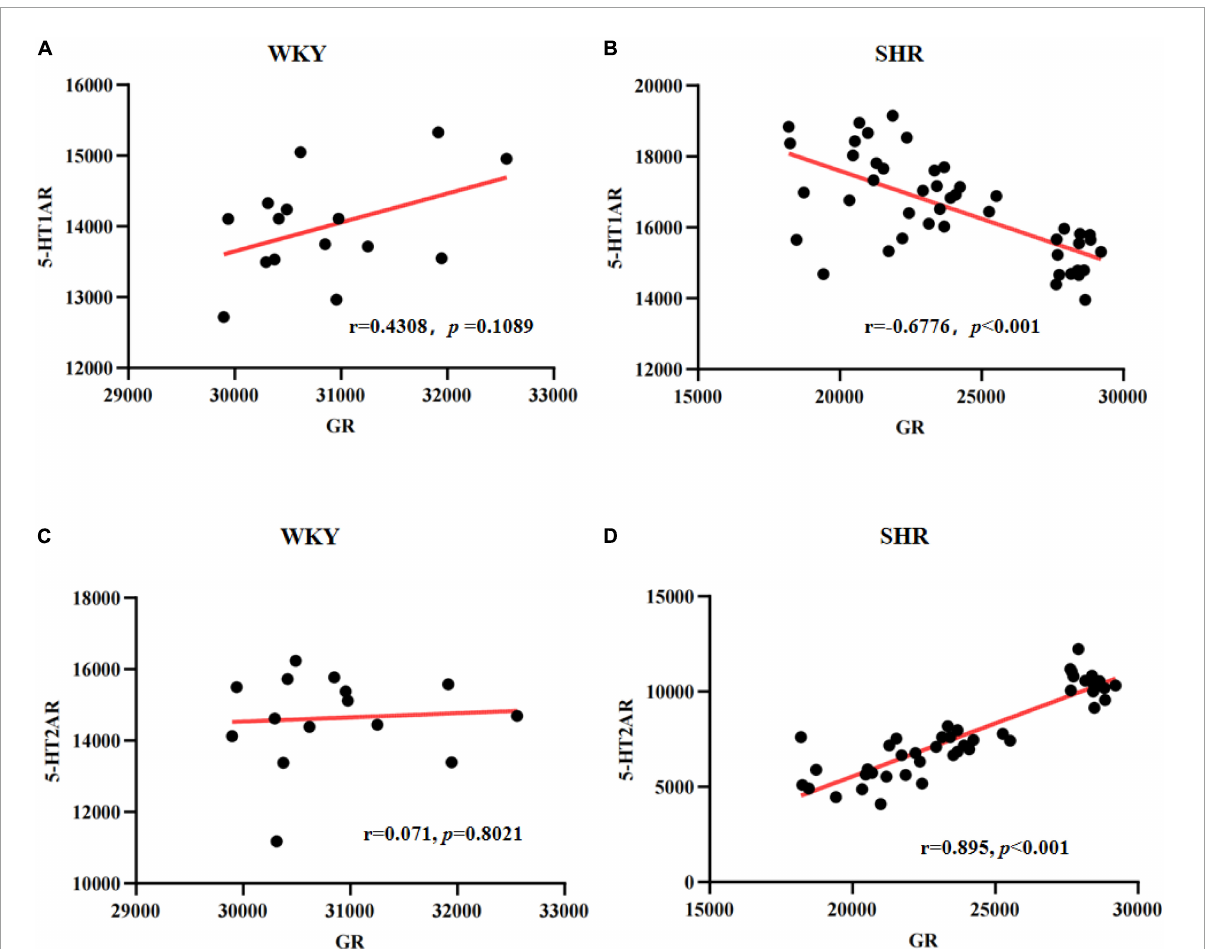
FIGURE8 Scatter plots for the correlation between glucocorticoid receptor (GR) and 5-HT1A receptor (5-HT1AR) or 5-HT2AR in spontaneously hypertensive rats (SHR) or Wista Kyoto (WKY) rats: Correlation between GR and 5-HT1AR in WKY (A) or SHR (B) ; Correlation between GR and 5-HT2AR in WKY (C) or SHR (D)